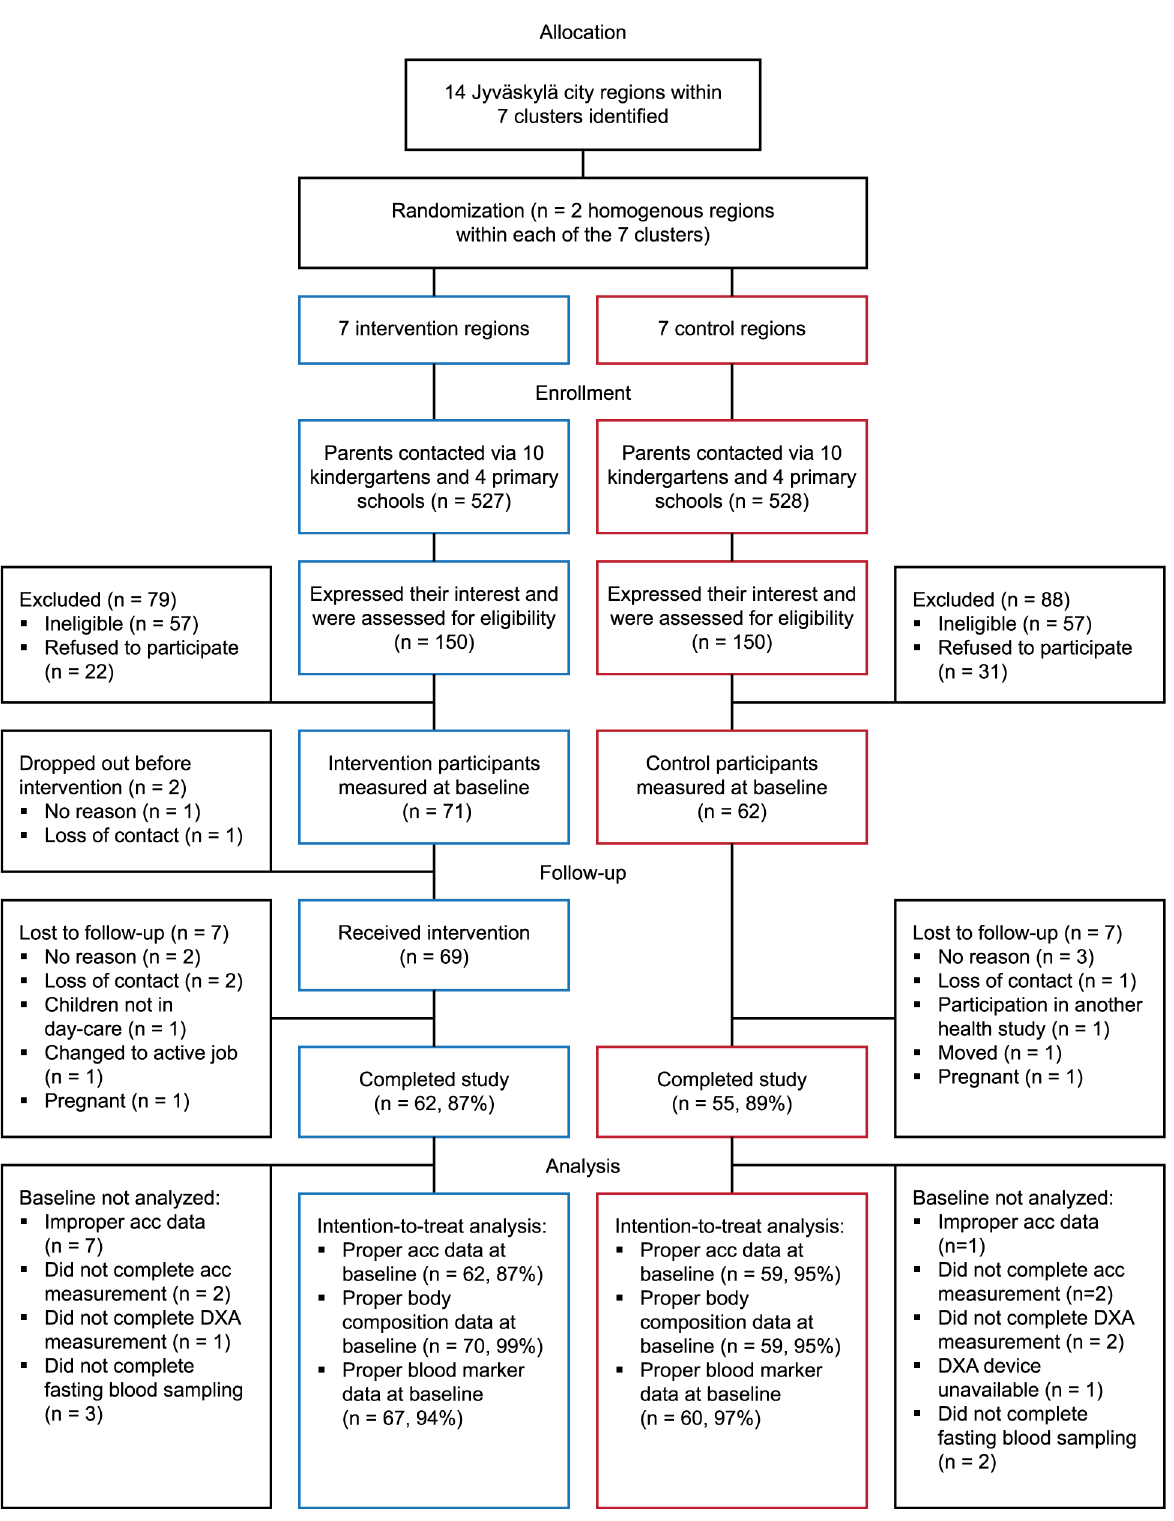
PLOS ONE | https://doi.org/10.1371/journal.pone.0183299 August 24, 2017 4 /